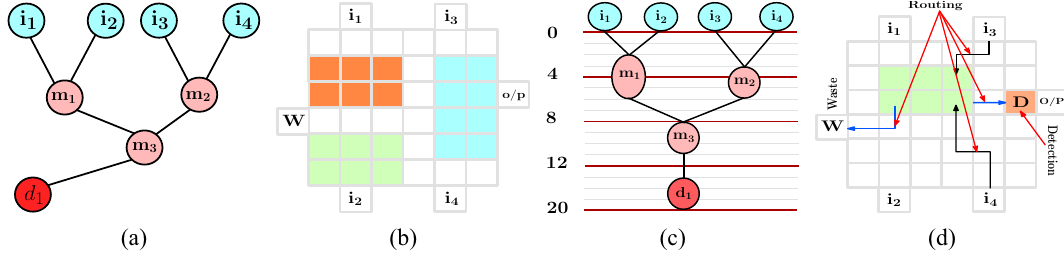
Fig. 2 Synthesis steps on a cyberphysical MEDA biochips